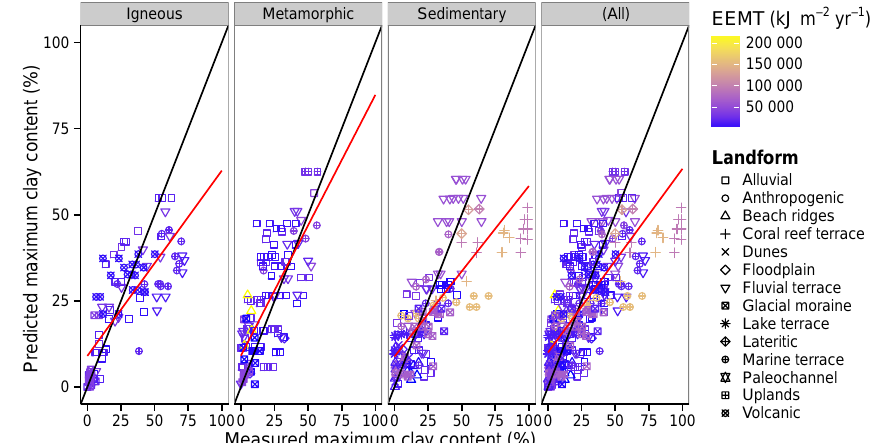
Figure 5. LOOCV results for max clay content. The results were subdivided by general soil parent material: igneous, metamorphic, and sedimentary; the points represent the geomorphic surface each soil formed on, and the colors represent the EEMT value for the location of each soil. Using LOOCV, where one chronosequence was removed from the model dataset and the remaining datasets were used to predict the parameters of the bivariate distributions, the conditional means of the left-out chronosequence was determined. The model was effectively able to predict the conditional mean values of the max clay contents with an r 2 = 0 . 54 (RMSE = 14.8%). The model was least capable of predicting the clay contents on coral reef terraces ( + ) and appeared the most effective for alluvial surfaces ( (cid:3) ).